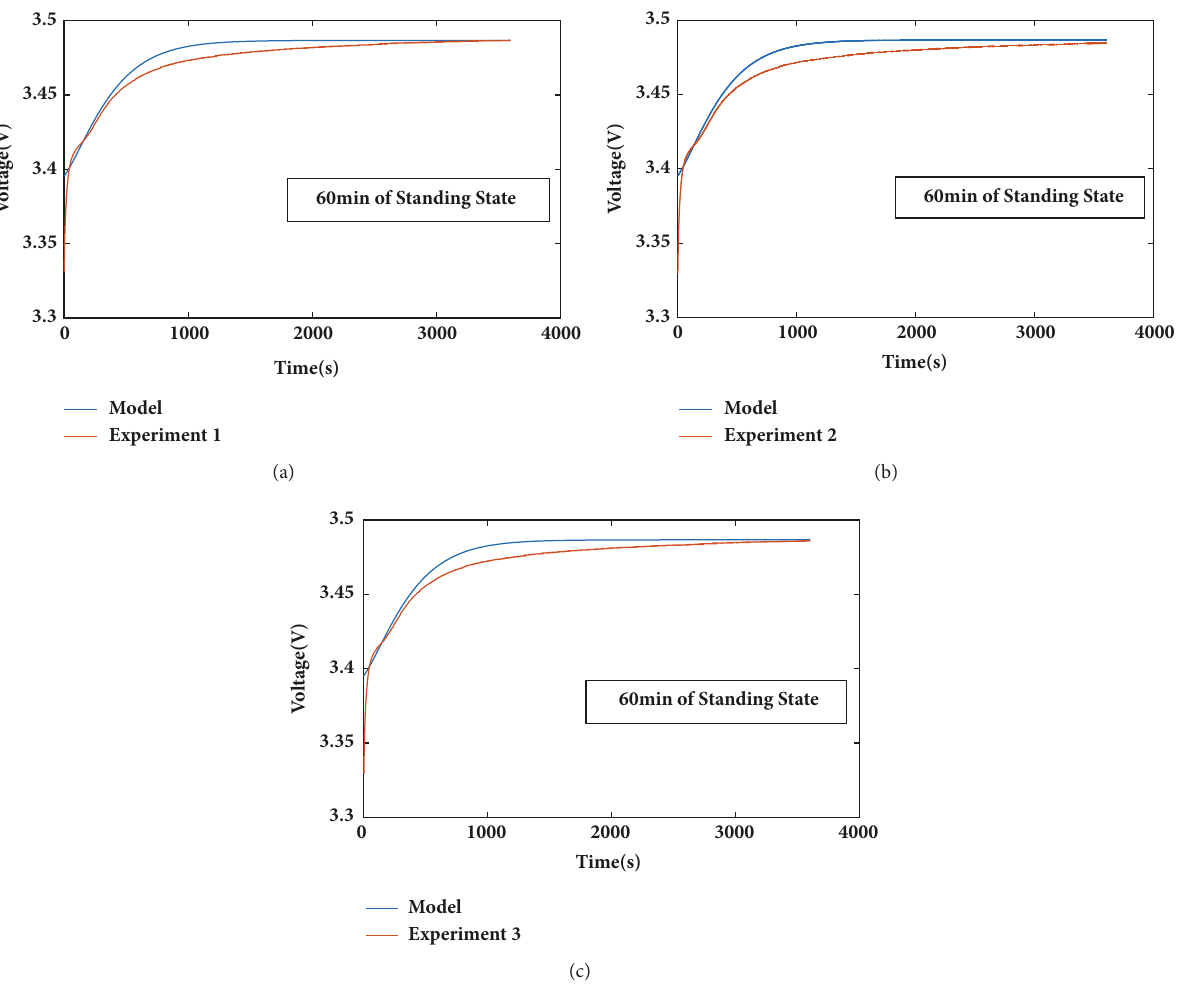
Figure 8: Comparison of model simulations and measurements at self-healing time of 60 minutes: (a) experiment 1, (b) experiment 2, and (c) experiment 3.